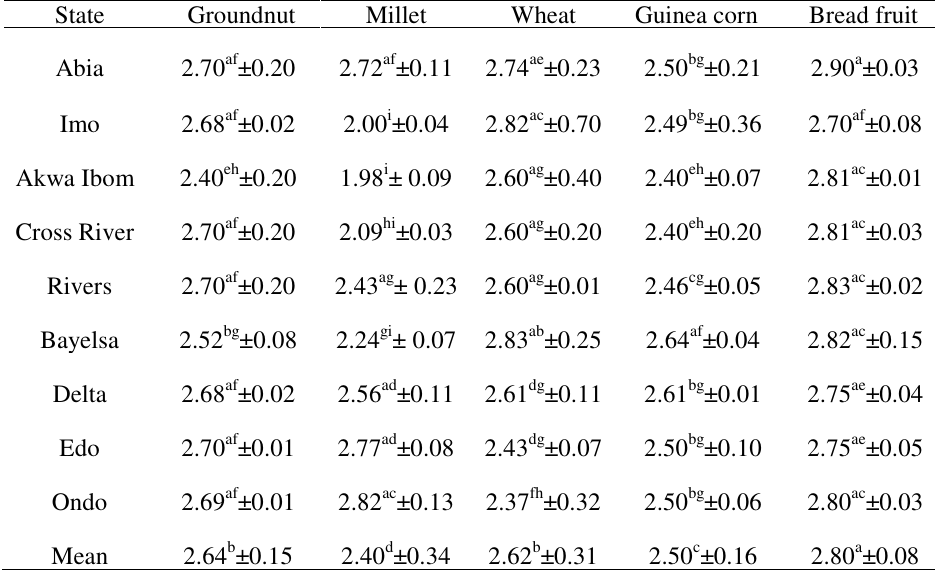
Values are mean ± S.D of three determinations. Values not sharing common superscript letter (s) in a column are significantly different at P<0.05. Table 6 . Phytic acid content of grains, (%).